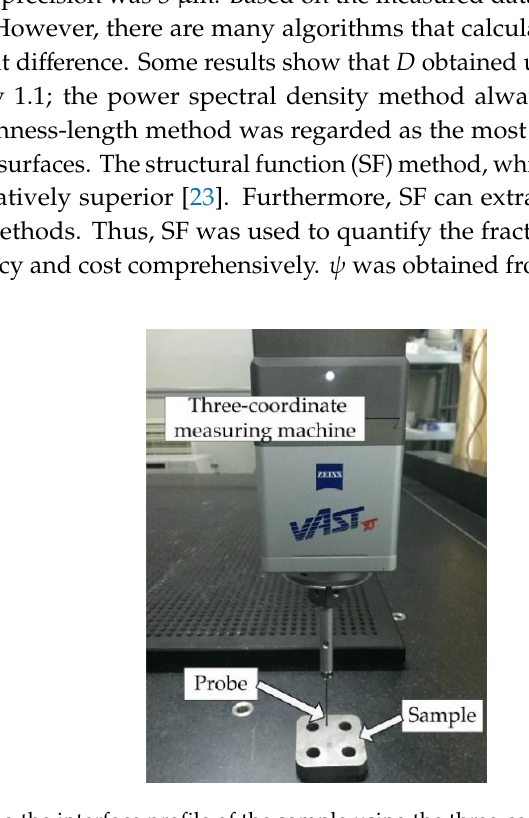
Figure 4. Measuring the interface profile of the sample using the three-coordinate measuring machine.